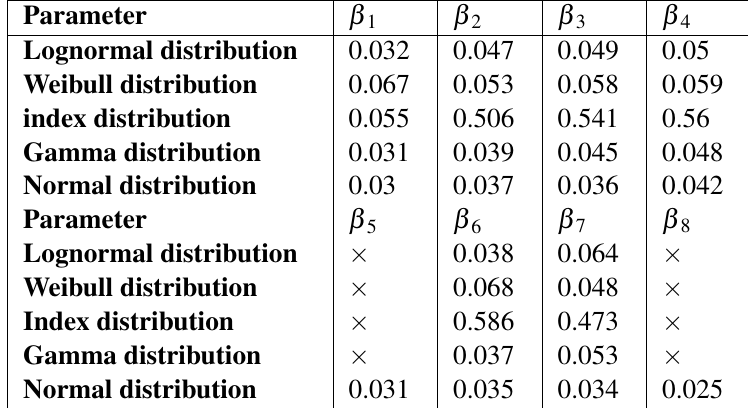
Table 2 Probability model parameter K − S test D